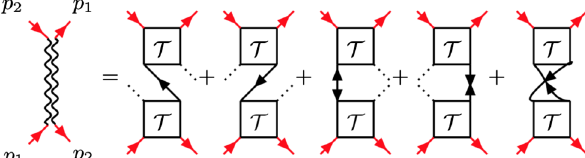
FIG. 7. Diagrams for the induced interaction obtained from the self-energy diagrams in Fig. 6. We omit the last diagram in the